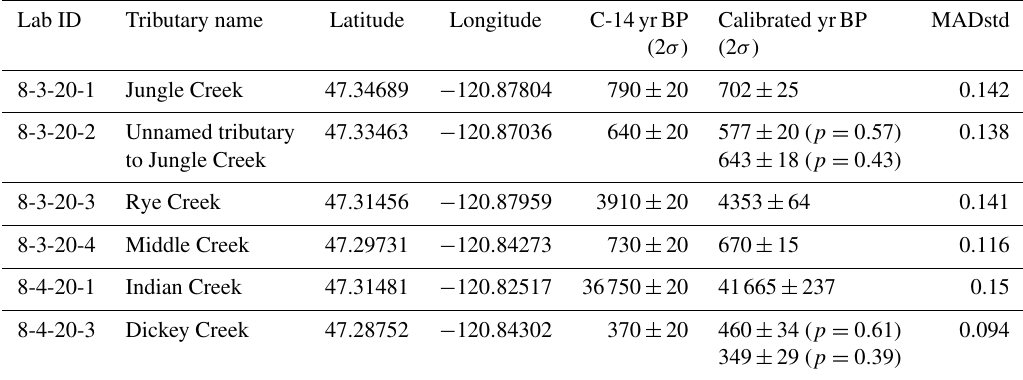
Table 1. Radiocarbon